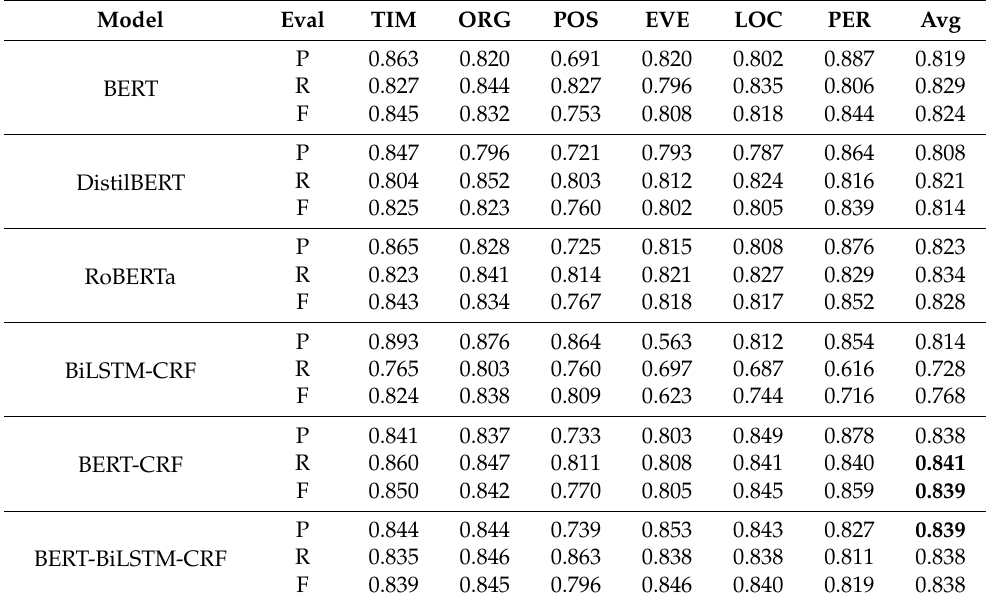
Table 4. P, R, and F1 scores of six types of entities on six models. The numbers in bold font are the three indicators (P, R, F1) with the highest corresponding scores in the